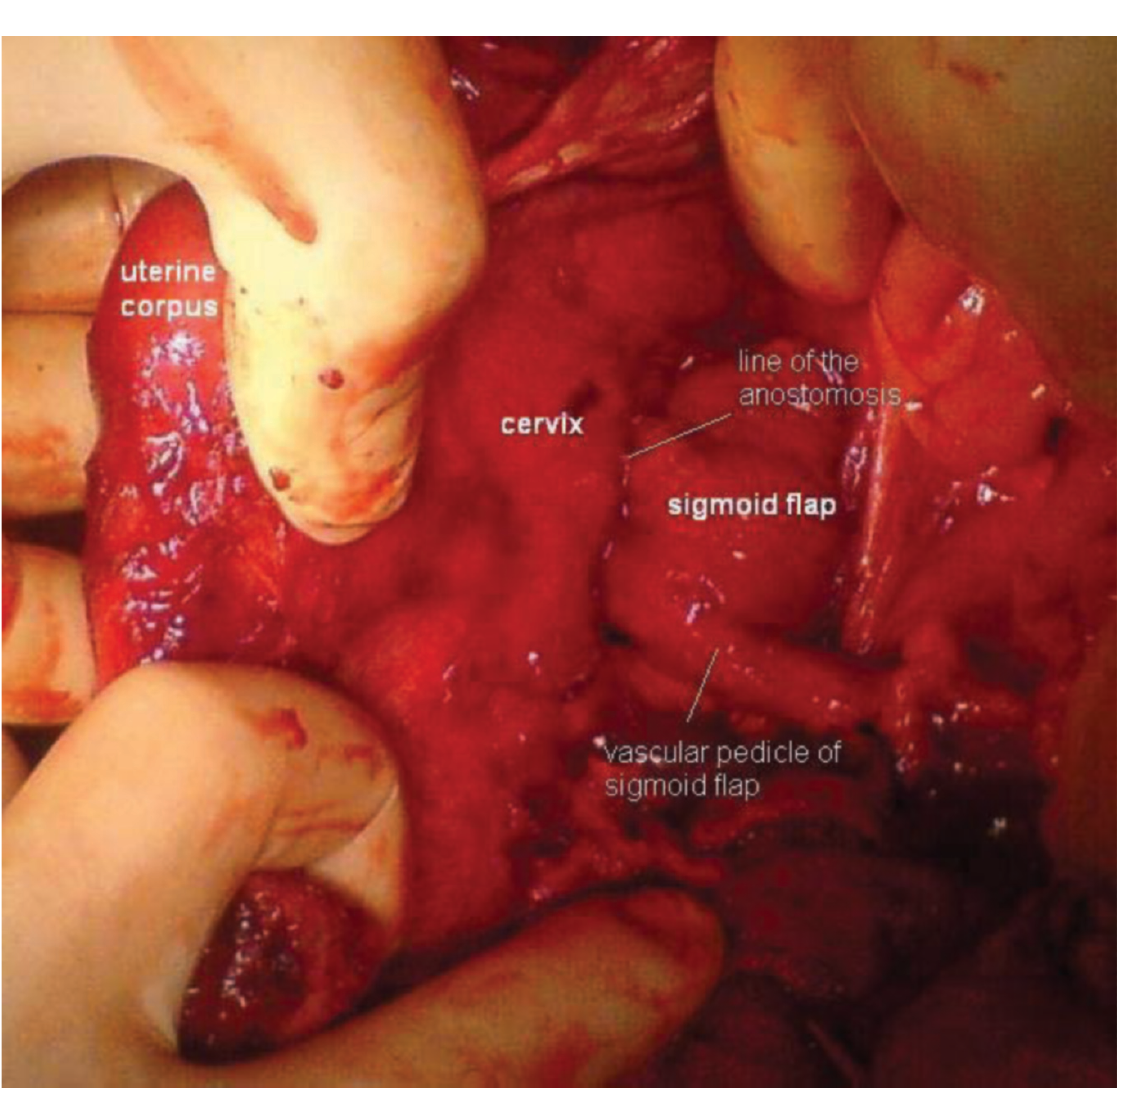
Figure 2. Posterior view of the sigmoidocervical